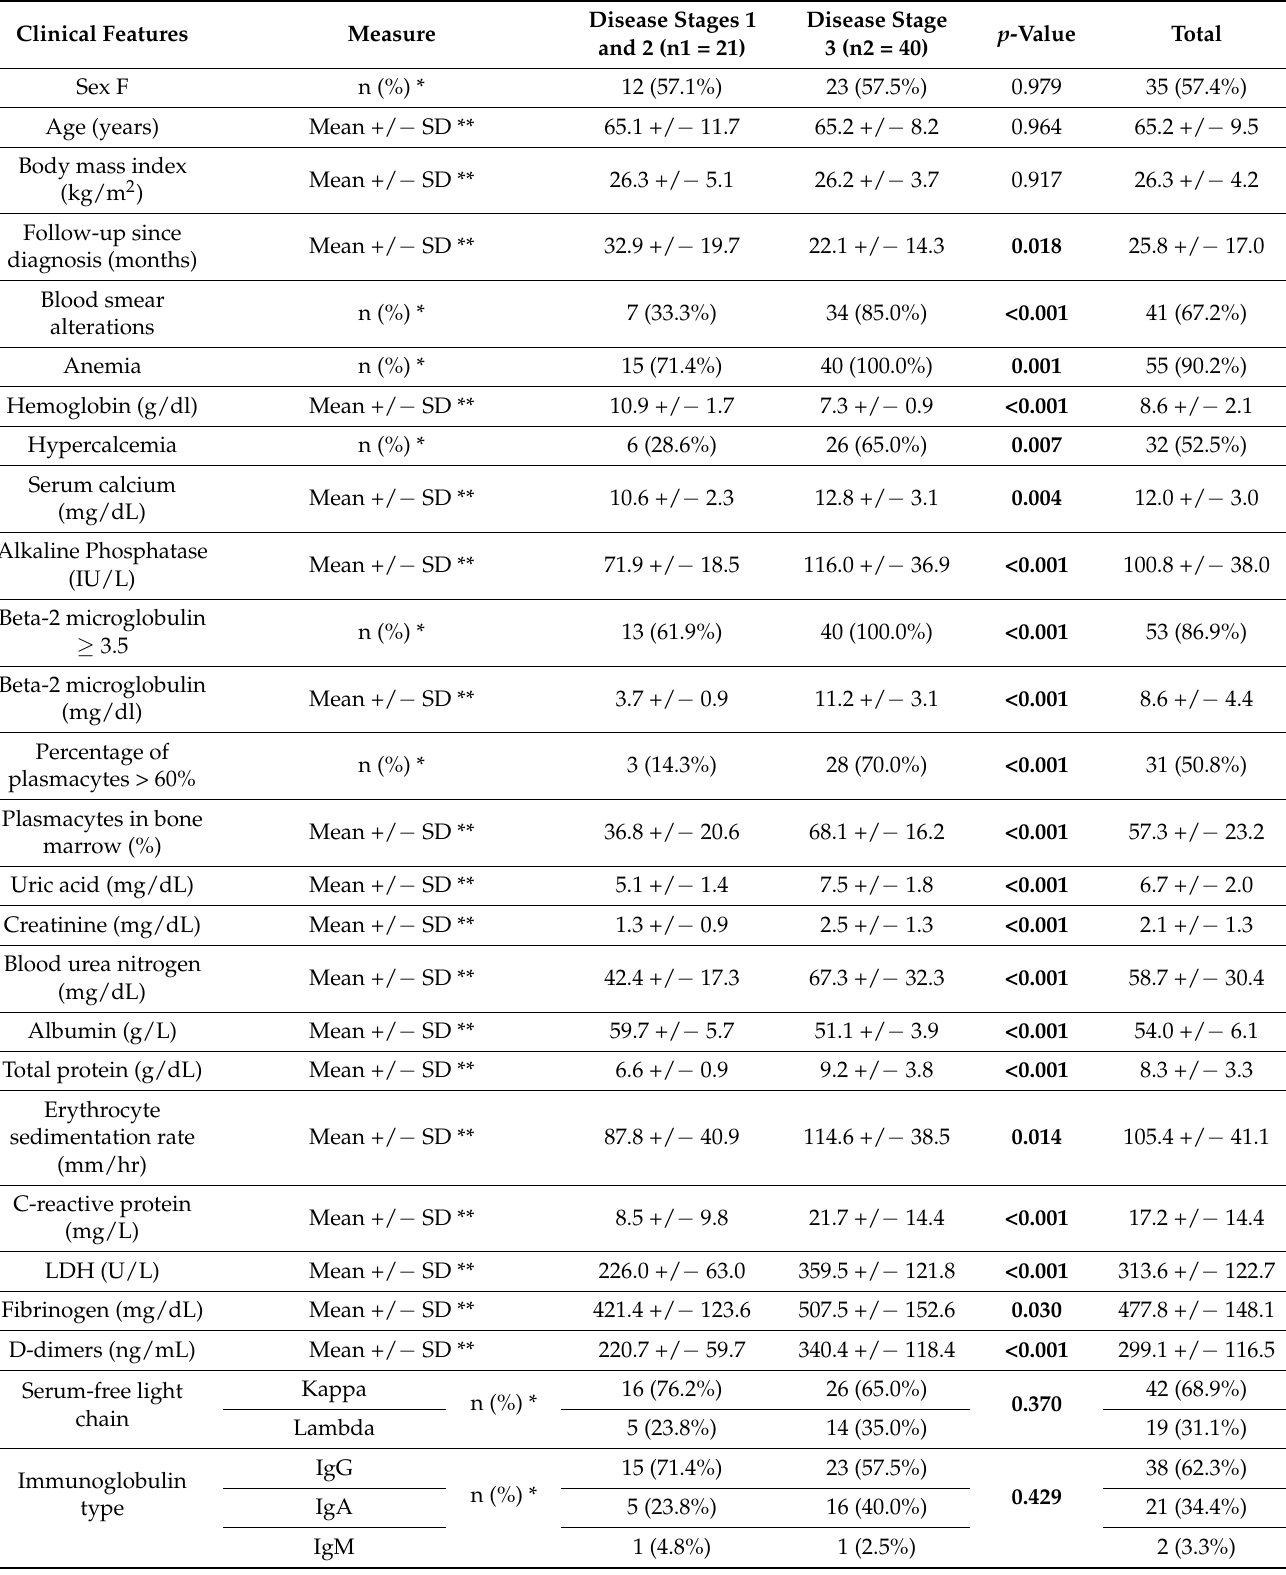
Table 1. Clinical features of the cohort of patients with a diagnosis of MM by disease staging (N =